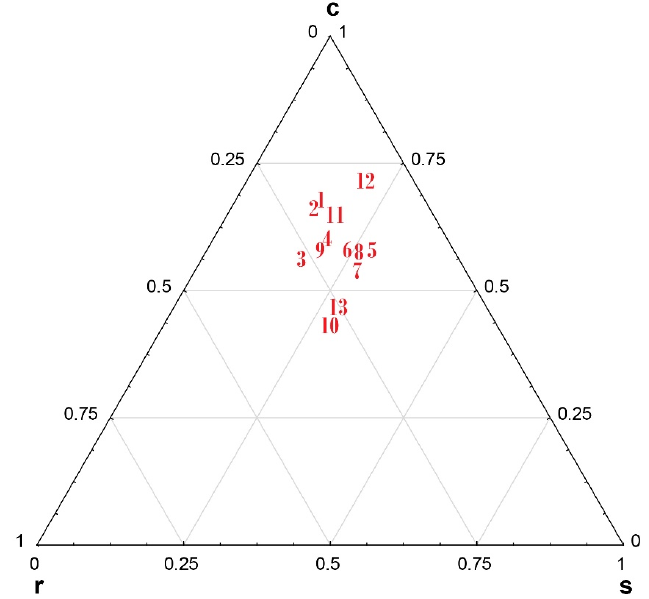
Figure 3. Functional signature of grassland types. Diagram with ecological strategies: competitor (indicated as c), stress-tolerator (s), and ruderal (r). (According to [27,29].) Legend: numbers correspond to those in Figure 2. Table 1. Spearman rank order correlations of forage quality with EIV Nutrients, EIV Moisture, habitat preference of species, functional groups, ecological strategies, and management. Only correlations that meet criterion p > 0.001 are